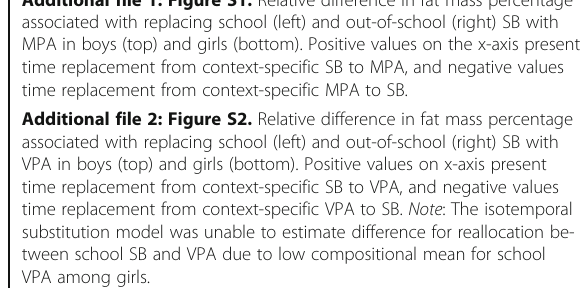
Additional file 3: Table S1. Descriptive characteristics of included and excluded